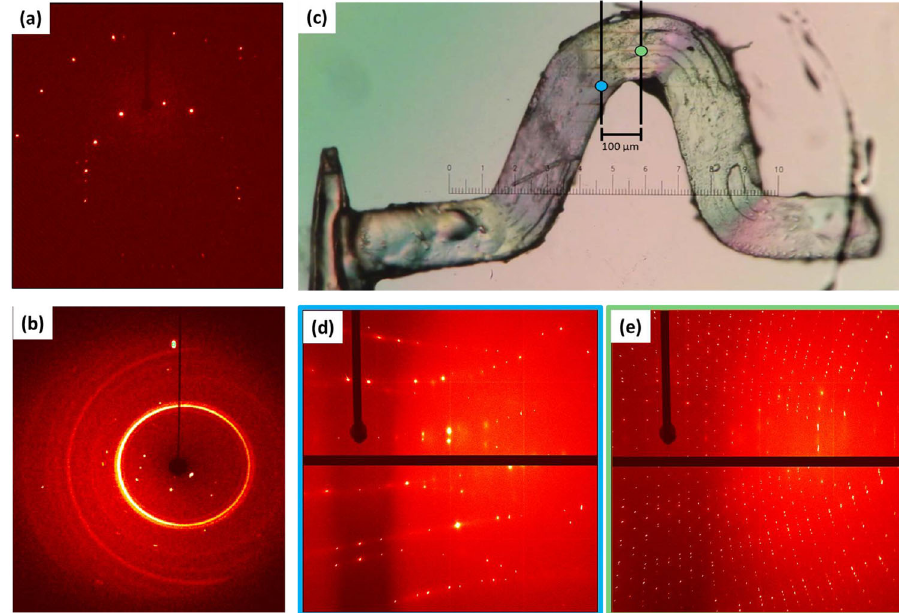
Fig. 5 2D X-ray diffraction images collected for single crystals of (1) in the hk0 direction. a Data collected by laboratory diffraction for unstressed crystals. b Data collected by laboratory diffraction for a single crystal at 9.34 GPa. Note that diffraction rings correspond to scattering from the gasket of the high-pressure cell. c Data collected by microfocus synchrotron diffraction within the bent region of the displayed plastically bent crystal. Diffraction images are shown as collected in the centre ( e ) of the bend, and 100 µ m displaced from the bend ( d ). Note each increment on the scale bar corresponds to 8.33 µ m. Further microfocus diffraction images are shown in Supplementary Note 7.